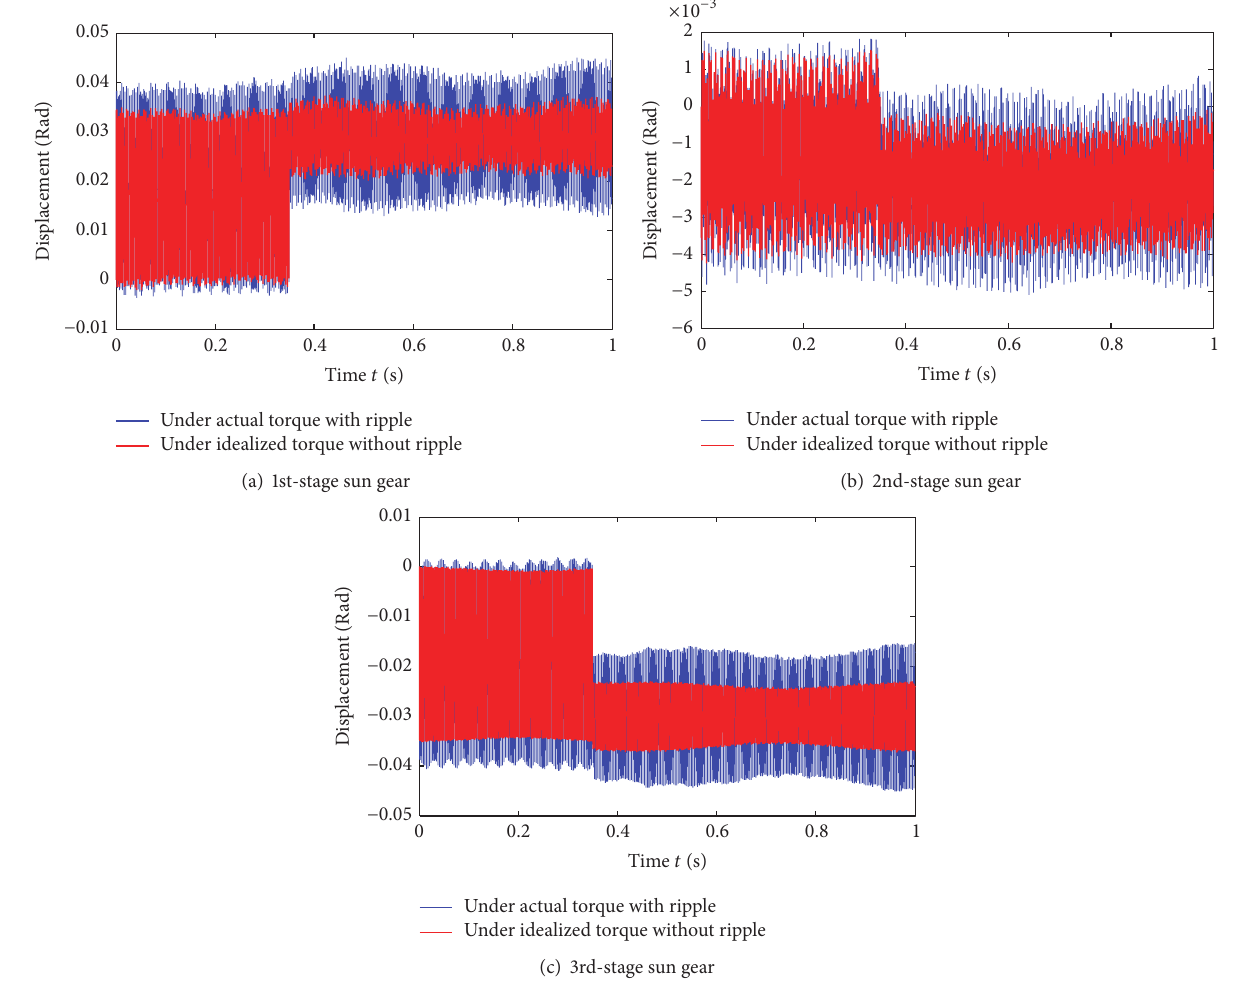
Figure 11: Dynamic response of sun